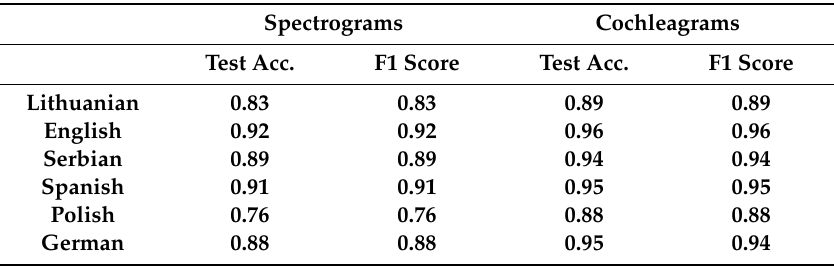
Table 7. Classification test results for spectrograms and cochleagrams: all datasets are used for training. The datasets that were used in the training process are highlighted in bold